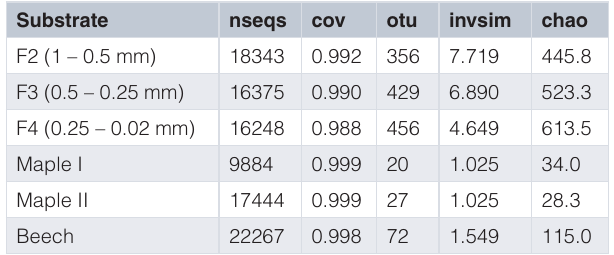
Table 2. Number of sequences (nseqs), coverage (cov), number of observed taxonomic units (otu), inverse Simpson index